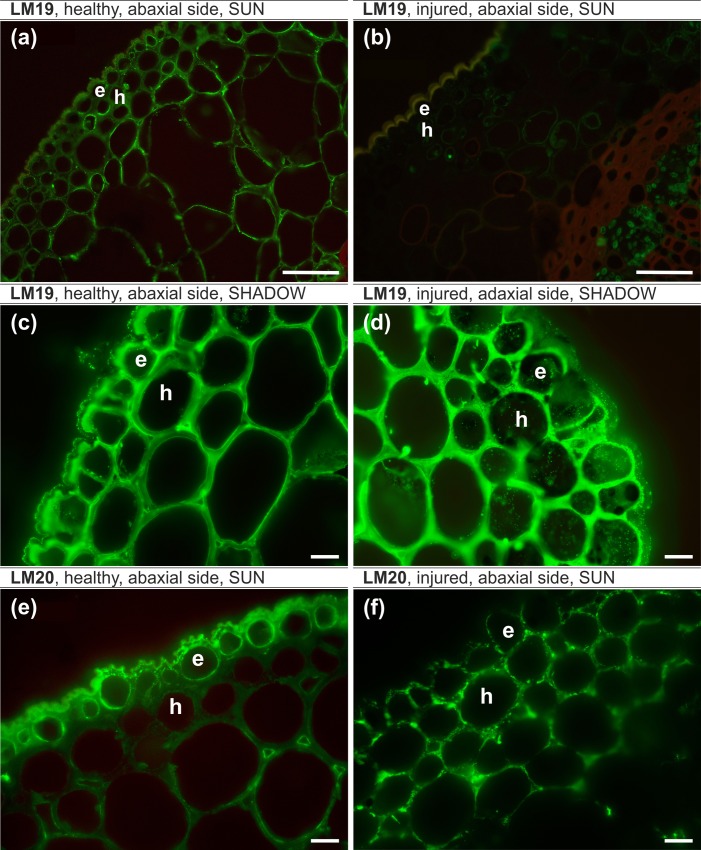
LM19 epitope, leaf lamina, sunlit side (a,b) LM19 epitope, leaf lamina, shady side (c,d) LM20 epitope, leaf lamina, sunlit side (e,f). (a,c,e) – healthy leaf, (b,d,f) – injured leaf, (a,b,c,e,f) – abaxial side, (d) – adaxial side. e – epidermal cells, h – hypodermal cells. Bars (a,b), 50 μm, (c-f), 10 μm.